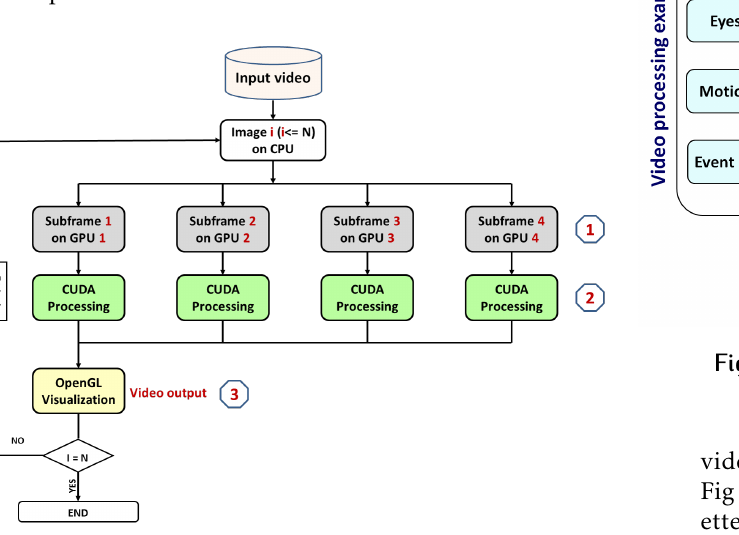
Figure 1. Multi-GPU based framework for real-time video processing (N : video frames number)